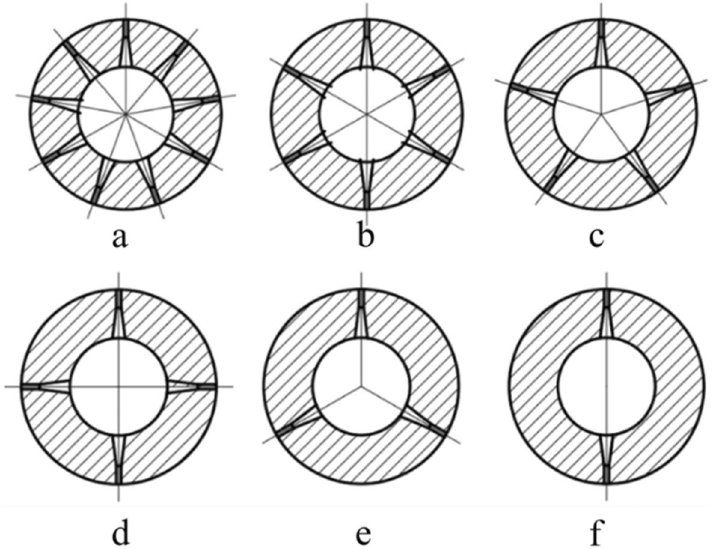
Fig. 13 Six nozzle arrangements. Number of nozzles in a single circle: a 9, b 6; c 5; d 4; e 3; f